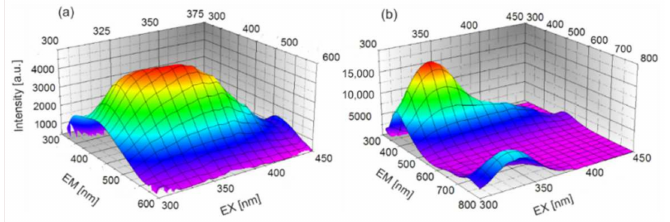
Figure 4. Emission–excitation characteristics (EM–EX) of ( a ) enamel and ( b ) dentin.